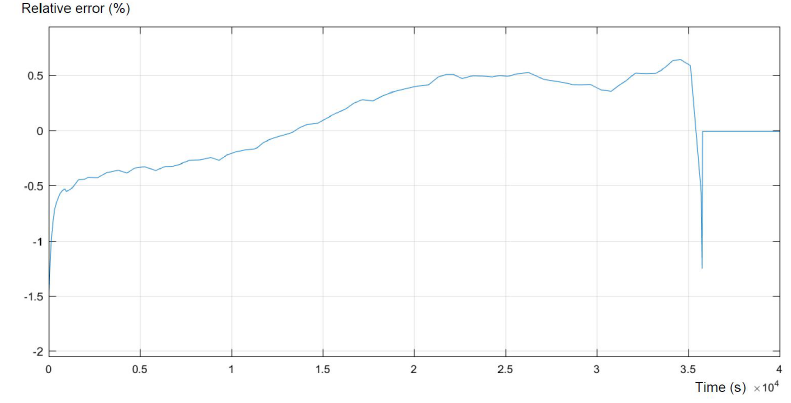
Figure 7. Relative error of the model.